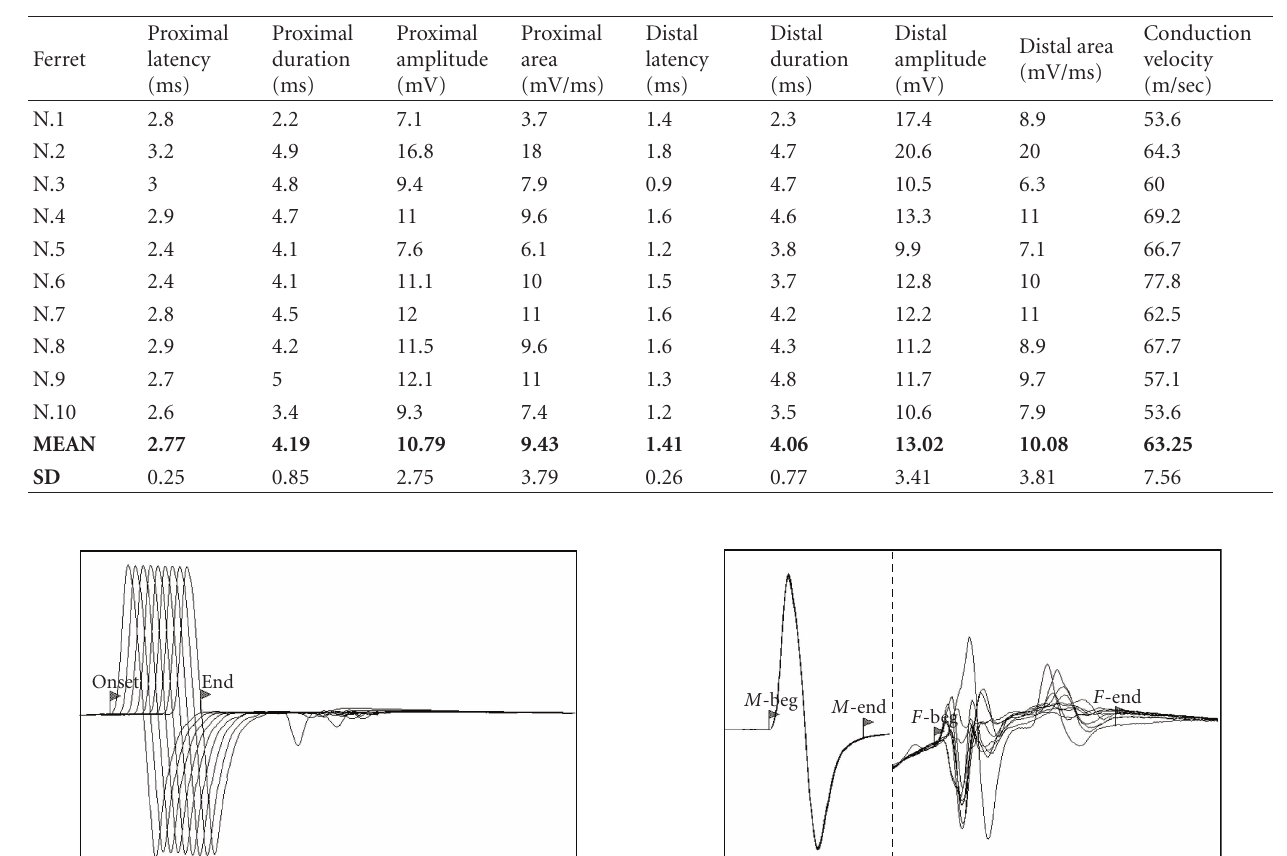
Table 1: Values of motor nerve conduction studies (MNCS) of sciatic-tibial nerve.